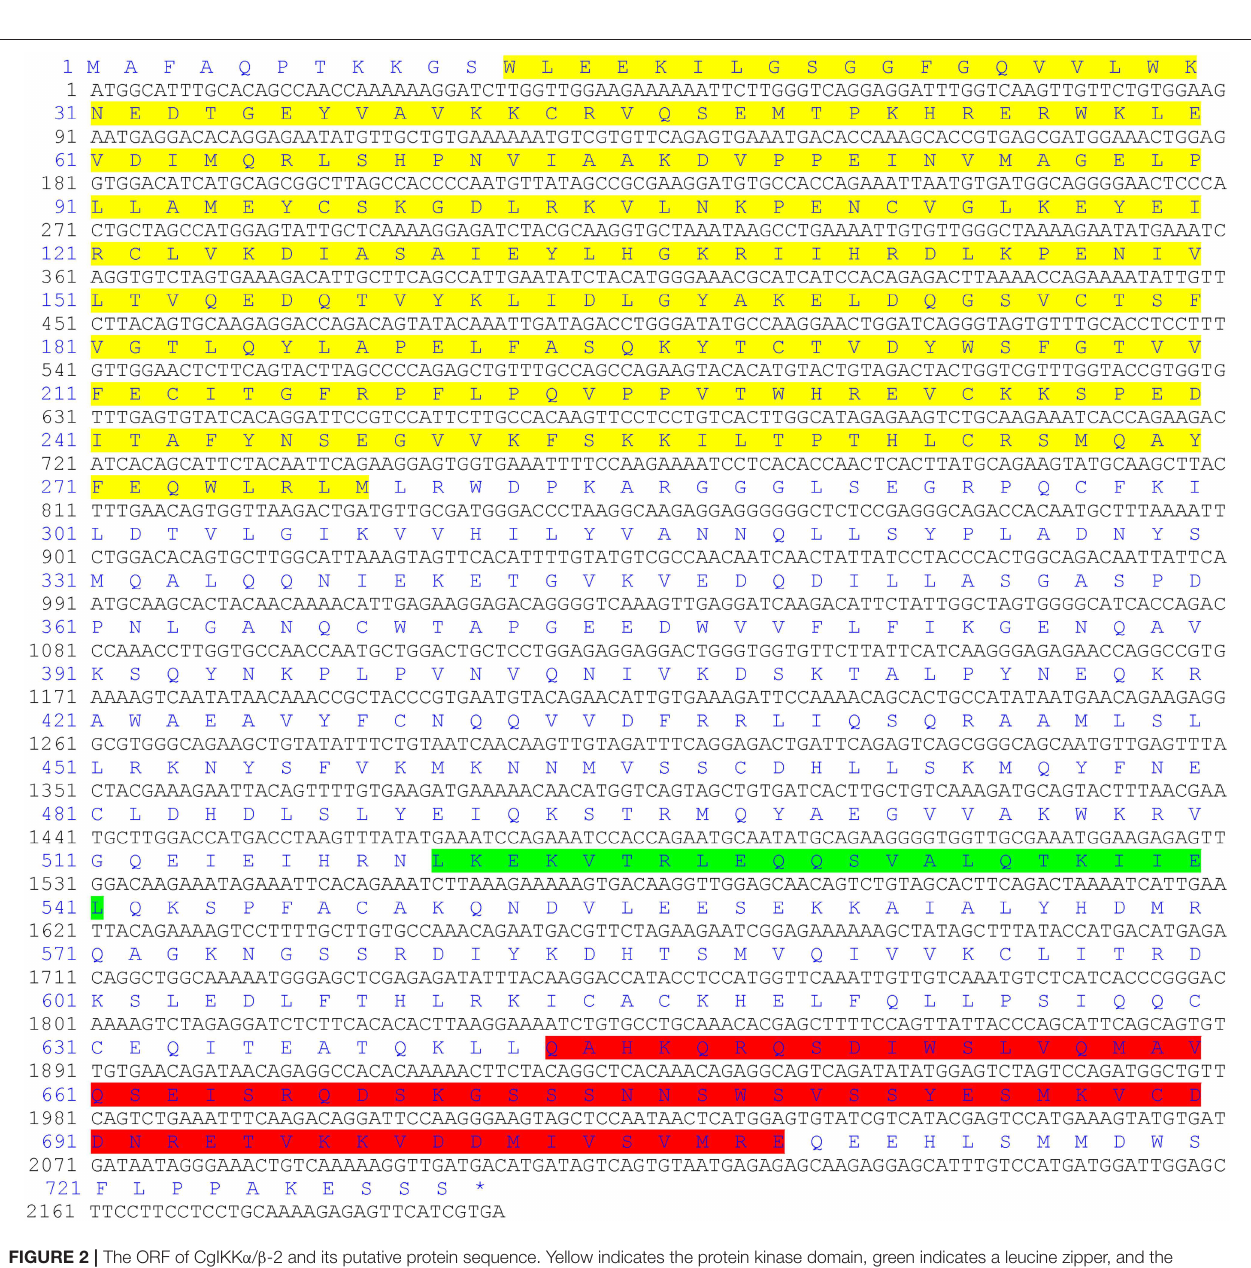
Frontiers in Immunology |